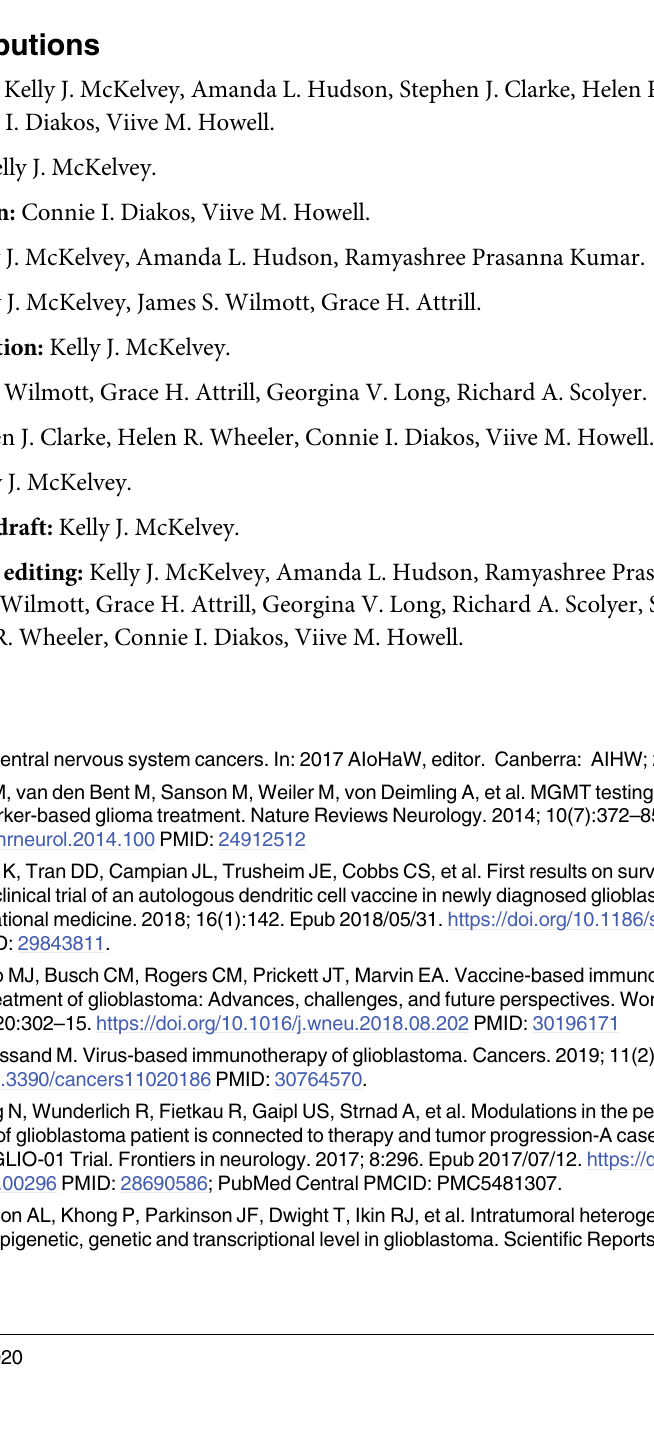
S5 Fig. Dynamics of the tumour and systemic immune response modelled using LOESS